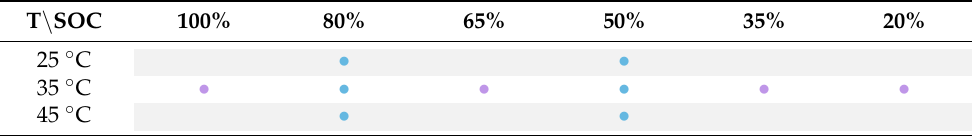
Table 1. Ageing test matrix for NMC/graphite cells (training data indicated with blue dots and testing data indicated with purple